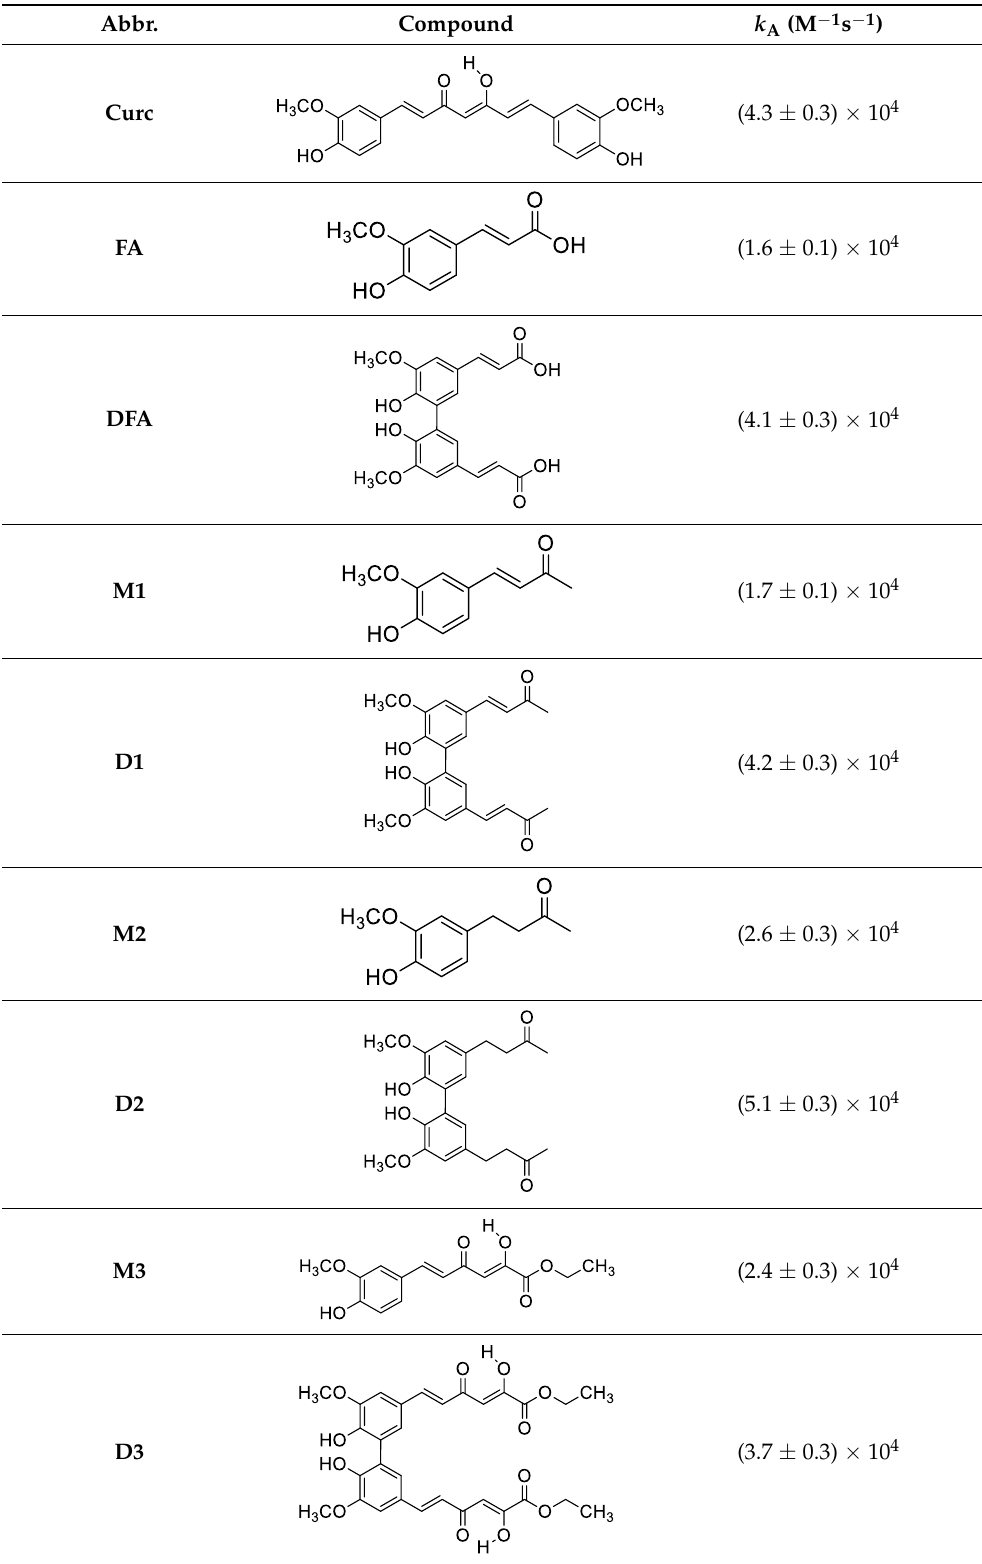
Figure 4. Time profiles of the relative CL intensity (I/I ∞ ) measured during the oxidation of ethylbenzene in the aerated chlorobenzene solution (26% vol.) initiated by AIBN at the rate of R IN = Table 4. The values of the effective rate constant ( k A ) of scavenging the peroxyl radicals of ethylbenzene by antioxidants. Abbr.